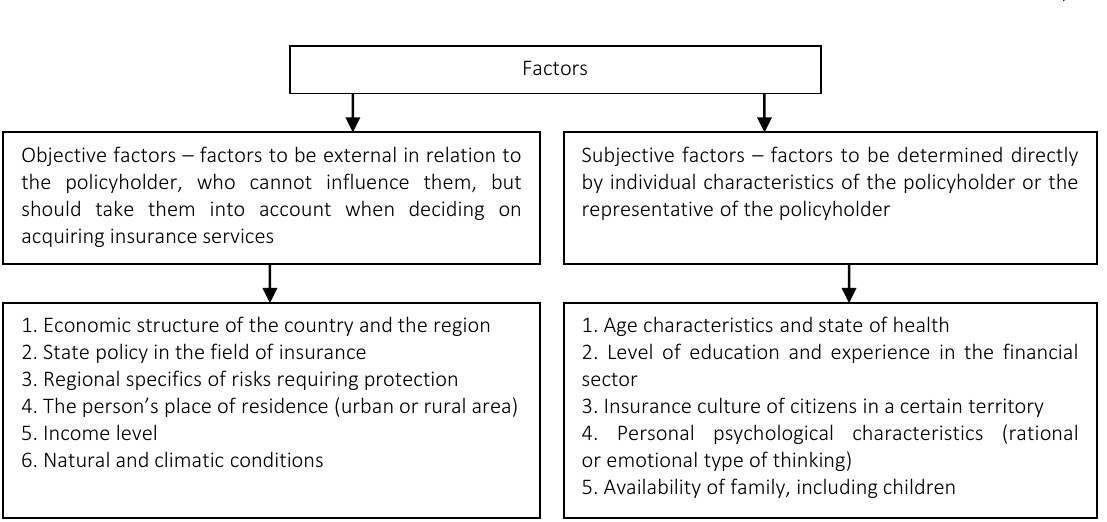
Figure 1. Factors determining the demand for insurance